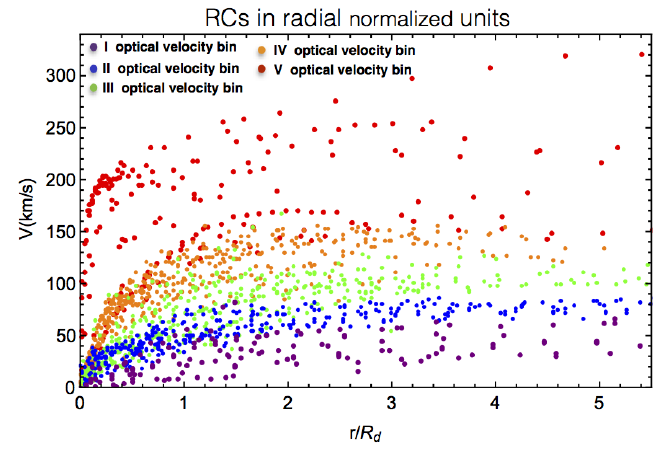
Figure 16. The [38] LSBs rotation curves (expressed in normalised radial coordinates) arranged in the I–V V opt velocity bins and drawn in purple, blue, green, orange, red colour, respectively. Image reproduced from [38].